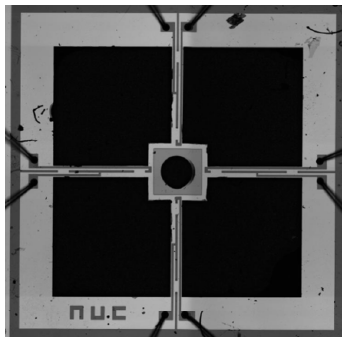
Figure 12. Optical microscope diagram of center block and cantilever beams.